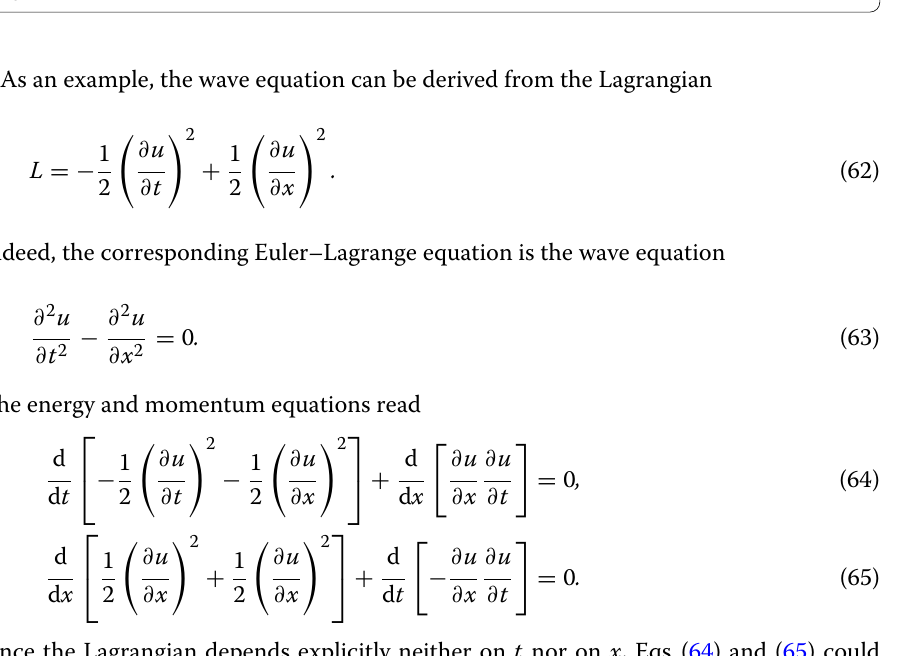
Fig. 18 Time and space